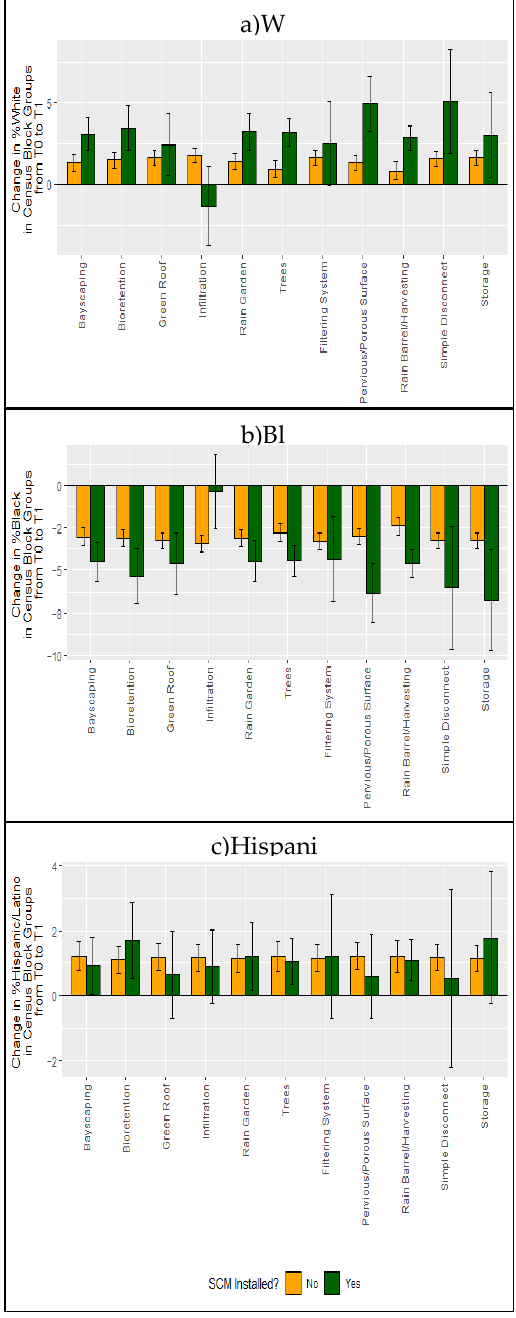
Figure 3. Change in percent of residents who are ( a ) White, ( b ) Black, and ( c ) Hispanic/Latino in Census block groups from the first 5-year interval (T0) to the last 5-year interval (T1) with or without stormwater control measure (SCM) installation of specific types. Error bars represent 95% confidence